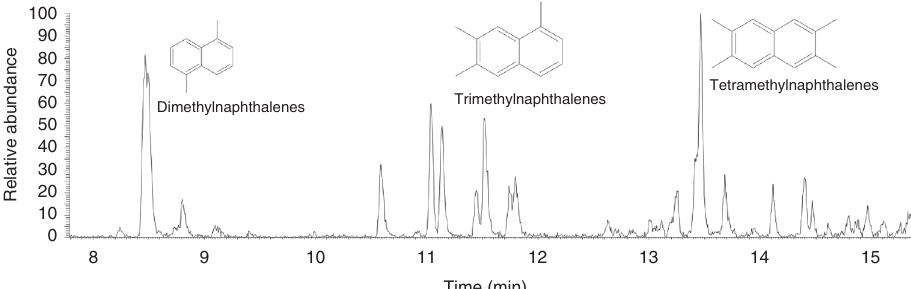
Fig. 3 GC – MS data of aromatic fraction. Fragmentograms m / z 156, m / z 170 and m / z 184: distributions of naphthalenes and its alkyl derivatives, from the